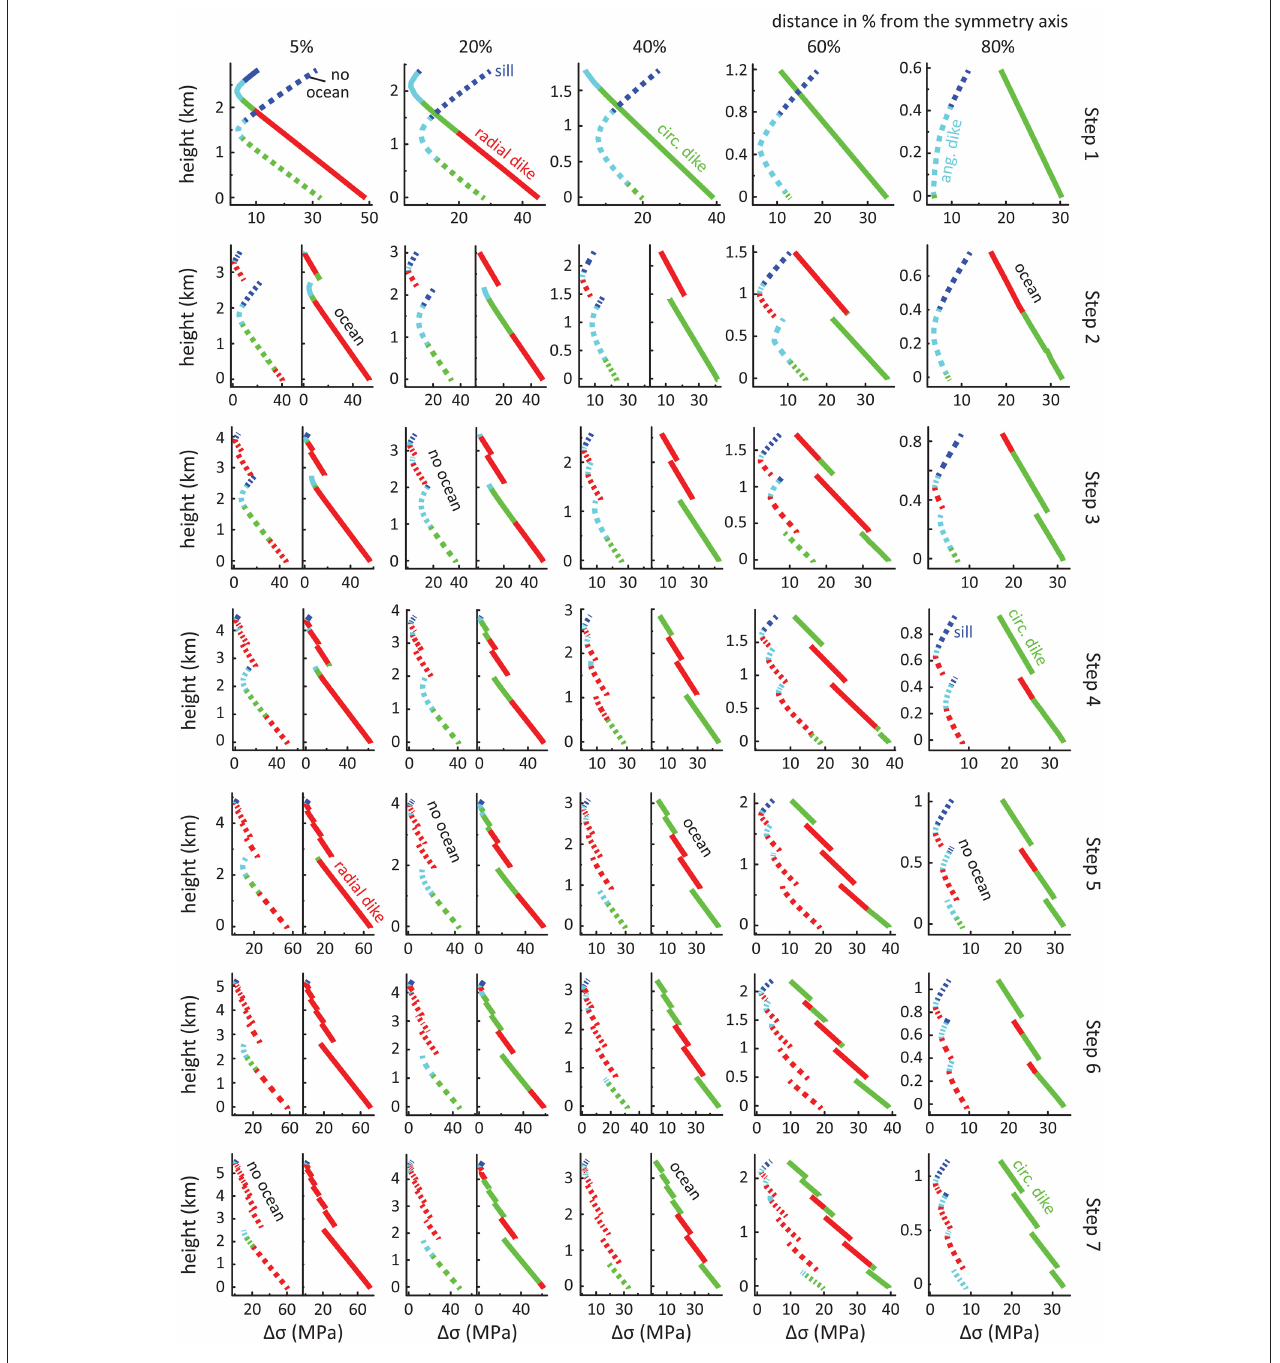
FIGURE 5 | Differential stress magnitudes, and magmatic intrusion types predicted from principal stress orientations along the internal cross-sections for incrementally-grown volcanoes in half-space models with and without an ocean load (solid and dashed lines, respectively). Legend as in Figure 3 .